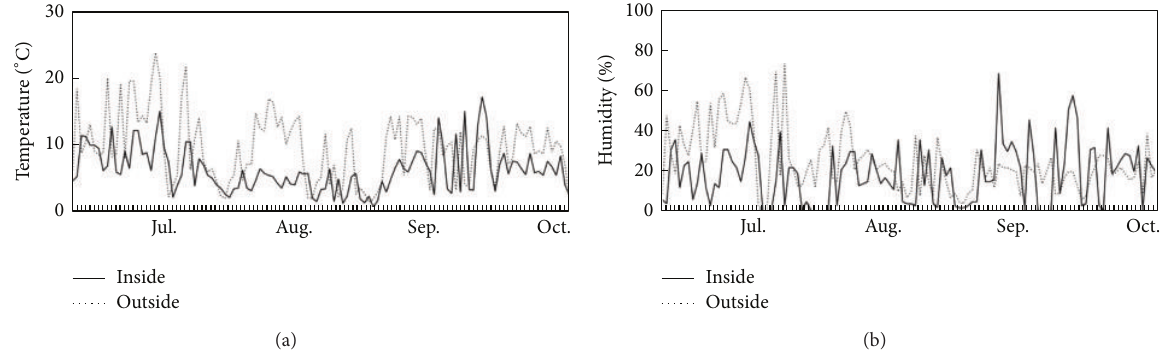
Figure 6: Diurnal temperature (a) and humidity (b) near the ground from late June to October, 2011 inside and outside the deer exclosure in Okutama, western Tokyo, Japan.